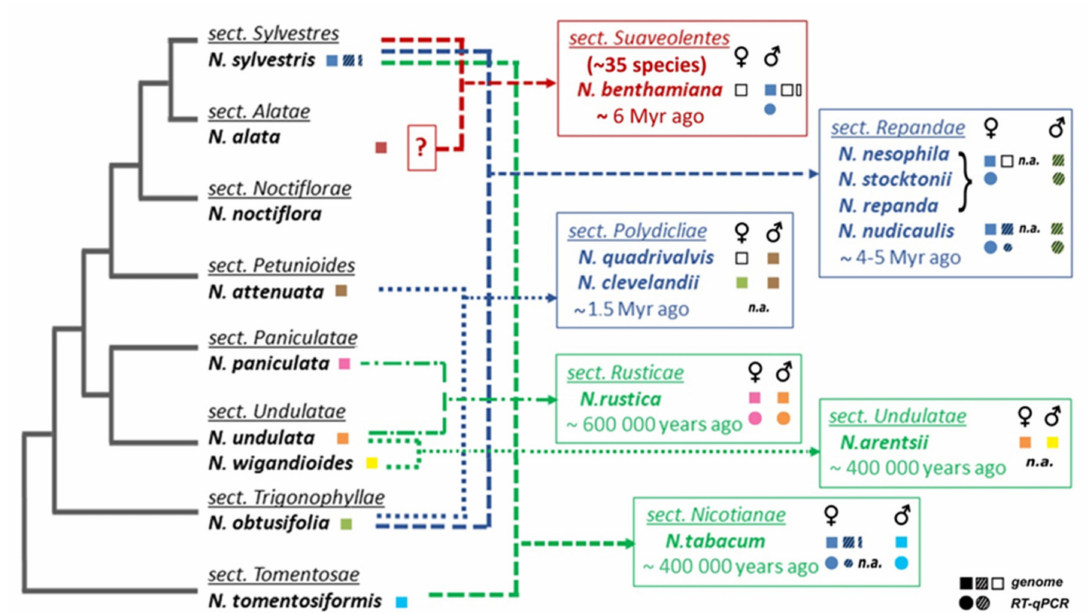
Figure 1. Overview of experimental results and illustration of phylogenetic relationships of Nicotiana species used in this study. Phylogeny and the proposed origin of polyploids were adapted from [31,32]. An uncertain parental genome donor for section Suaveolentes is indicated by a question mark. Summary of experimental and in silico results (squares, analyses of genomic DNA; circles, expression of TERT variants investigated by RT–qPCR) is shown in boxes of Nicotiana sections, the origin of TERT variant in polyploids is depicted by color of respective parental diploids, and variants that were not identified are depicted with open squares. Nicotiana accessions used in the experimental analyses are listed in Table S1, genomic assemblies and genomic/transcriptomic SRA data used for in silico analyses are listed in Material and Methods. For the purposes of this paper, we refer to a TERT copy that does not code for a catalytically active protein as a putative pseudogene (dashed symbols) in contrast to a functional TERT gene copy (open symbols), n.a. not